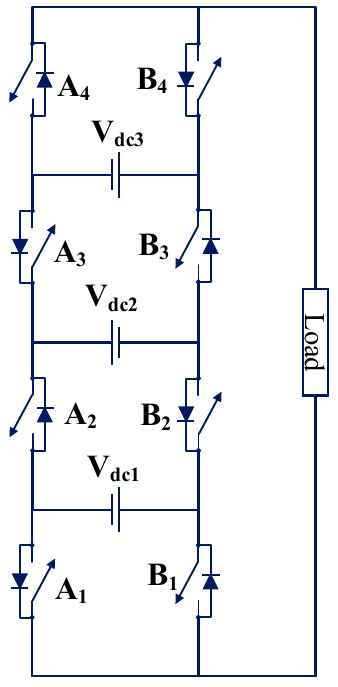
Figure 31. Single-phase seven-level FT MLI (TP34) [66].